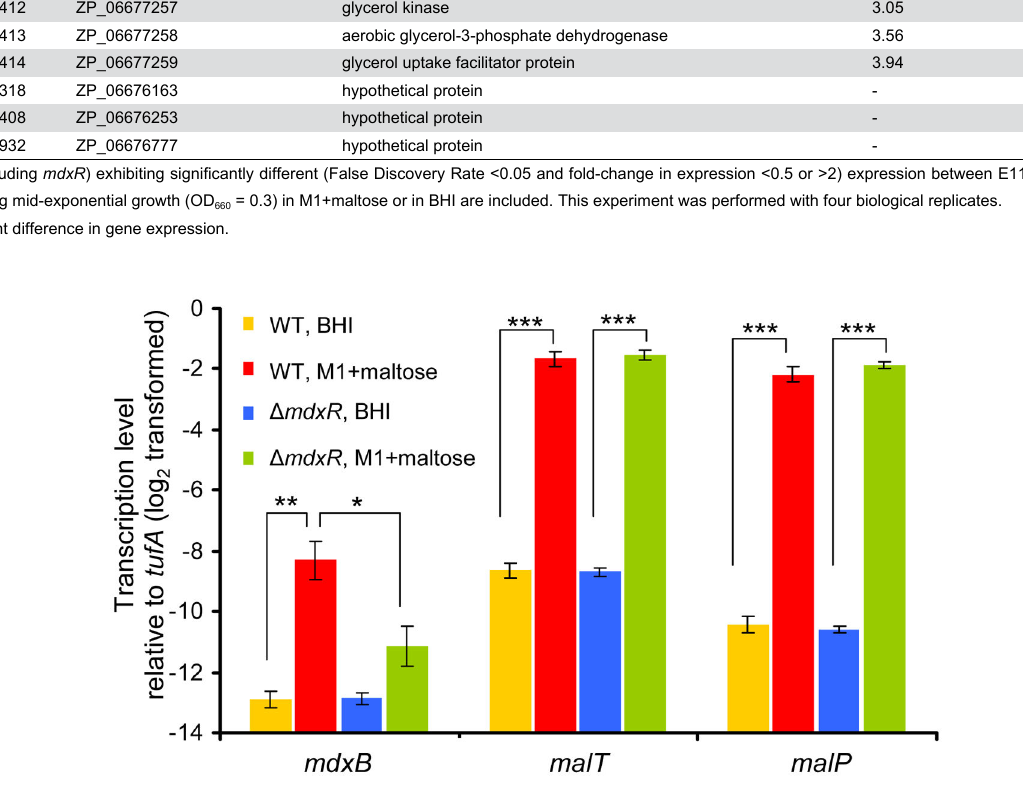
Figure 3. qRT-PCR analysis of mdxB, malT and malP expression ratios in wild-type E1162 and its isogenic mutant Δ mdxR grown in BHI and maltose. The data from the qRT-PCR were normalized using tufA as an internal standard [28]. The differences in gene expression (log -transformed data) relative to tufA are shown. Error bars represent the standard deviation of the mean of 2 four biological replicates. Asterisks represent significant differences (*: P <0.01, **: P <0.001, ***: P <0.0001, as determined by an unpaired two-tailed Student’s t -test) between the indicated samples. doi: